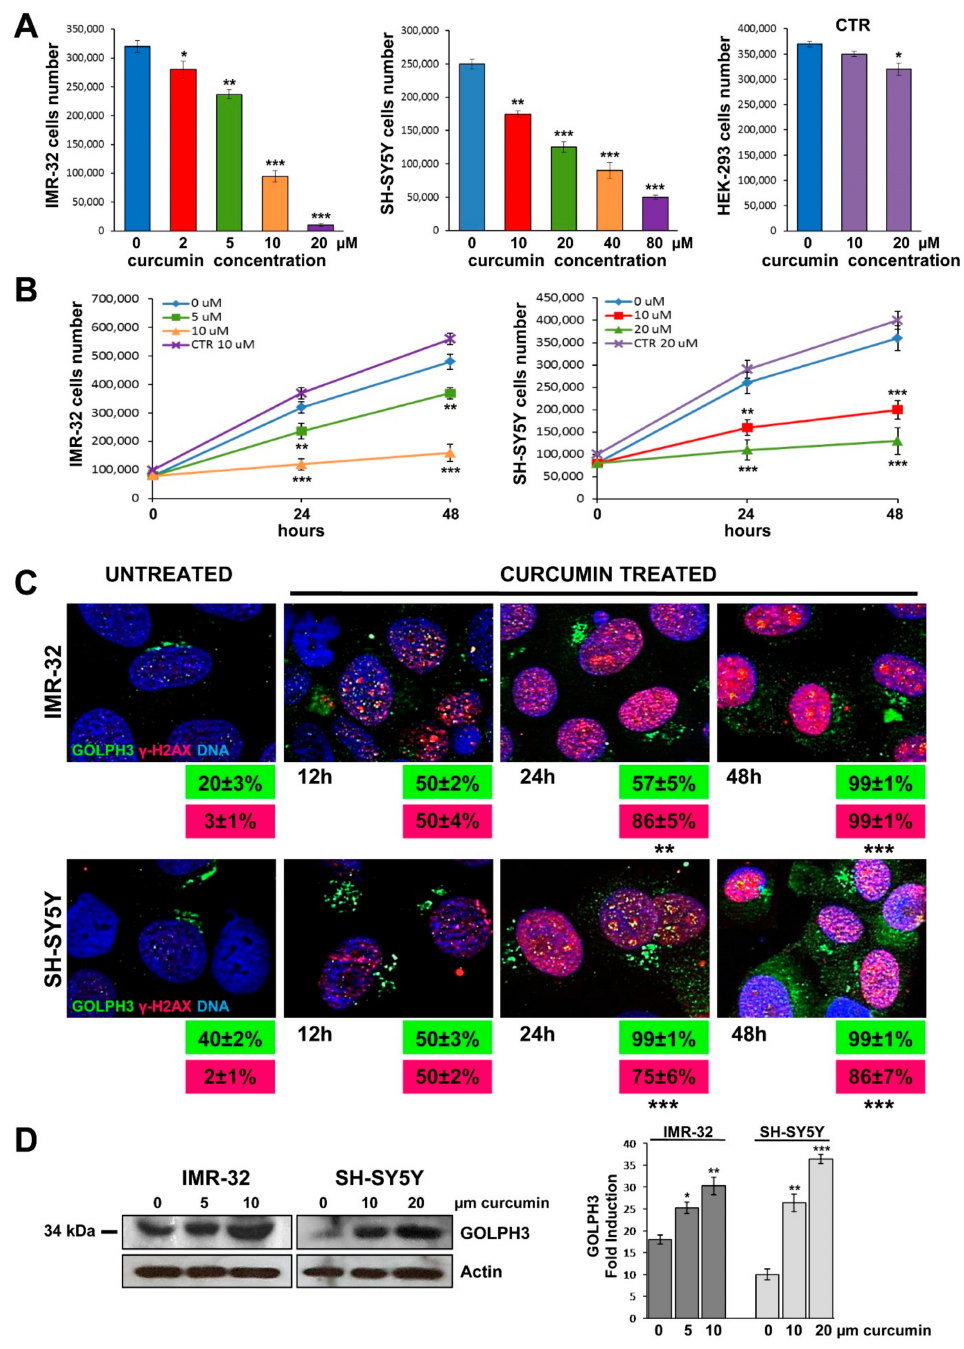
Figure 1. Curcumin provoked DNA damage in neuroblastoma cells and up-regulation of GOLPH3 with Golgi dispersal. ( A ) IMR-32, SH-SY5Y and non-tumorigenic control HEK-293 (CTR) cell lines were cultured in presence of various concentrations of curcumin for 24 h. ( B ) Cells were cultured with two curcumin concentrations for 24 and 48 h. At each harvest point, cells were trypsinized and counted in Trypan blue. Untreated cells (curcumin 0 µ M) were cultured with 0.1% DMSO. Non-tumorigenic control HEK-293 cells (CTR) were cultured with the highest curcumin concentrations used for each NB cell line. Data are representative of three independent experiments ± SD. ( C ) Immunofluorescence analysis of IMR-32 and SH-SY5Y cells cultured with 10 or 20 µ M curcumin respectively for 12, 24 and 48 h using anti-GOLPH3 (green) and anti- γ H2AX (red). Cells were counterstained with DAPI to visualize nuclei (blue). Untreated cells were cultured with 0.1% DMSO. (Magnification 40 × ). In green and red boxes are reported the percentages of GOLPH3 and γ H2AX positive cells